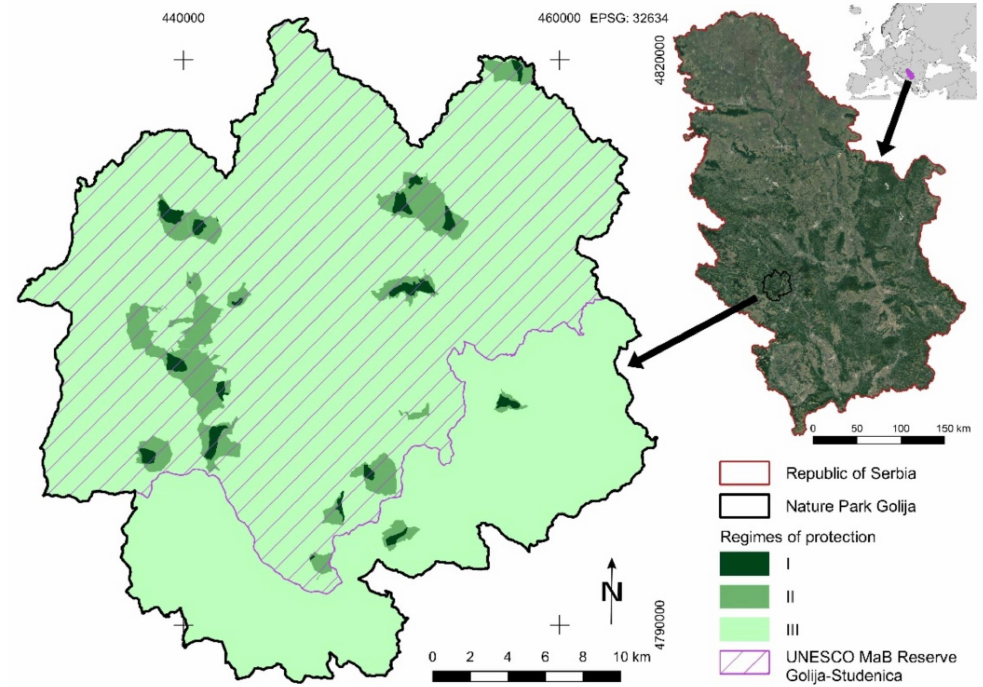
Figure 1. Location of Nature Park Golija and UNESCO Man and Biosphere (MaB) Reserve Golija- Studenica in Serbia Zones of protection regimes in the Nature Park